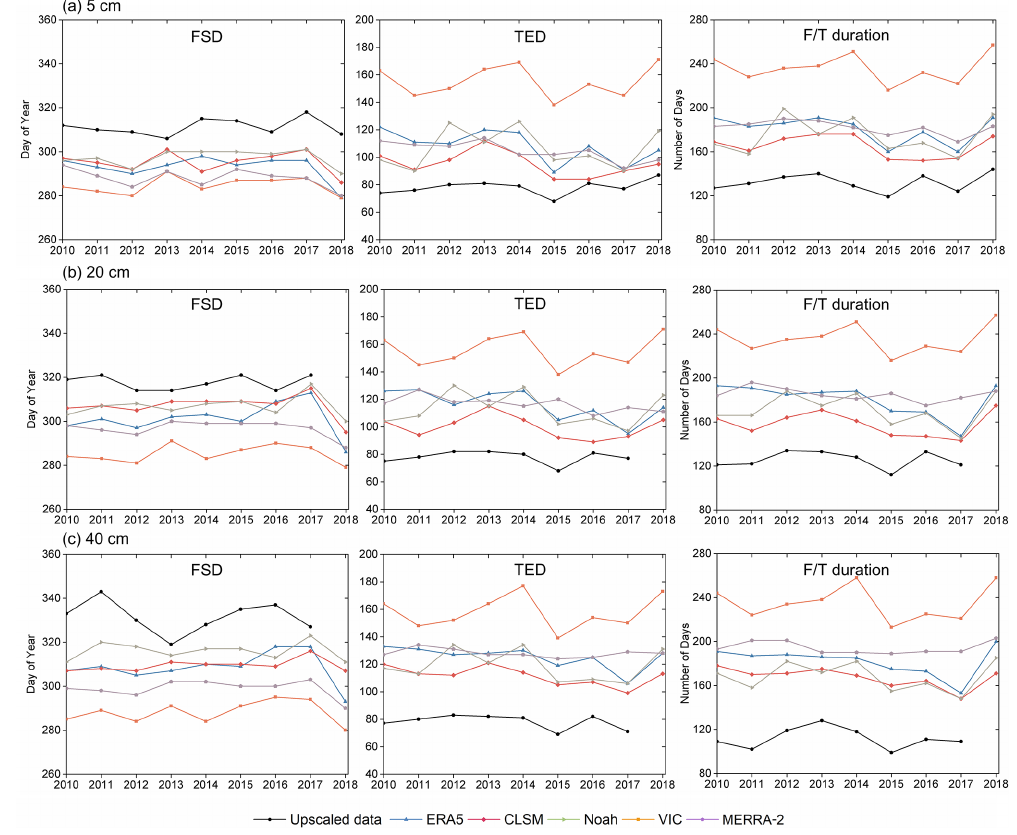
Figure 14. Same as Fig. 12 but for the Shiquanhe